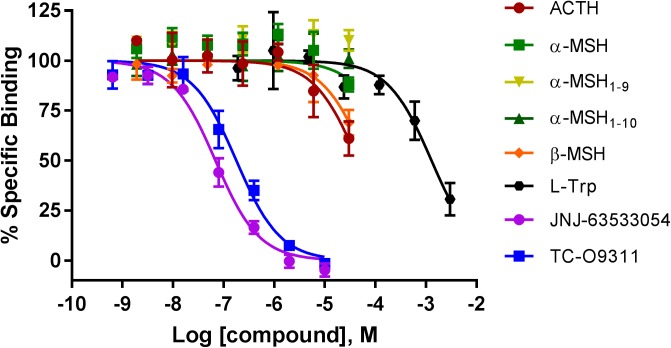
Competition of [3H]-JNJ63533054 binding by MC ligands ACTH, α-MSH, α-MSH1-9, α-MSH1-10, β-MSH, and GPR139 ligands L-Trp, JNJ-63533054, and TC-O9311 in CHO-TREx cells stably expressing human GPR139. Data are the mean ± SEM of at least three separate experiments performed in triplicates.